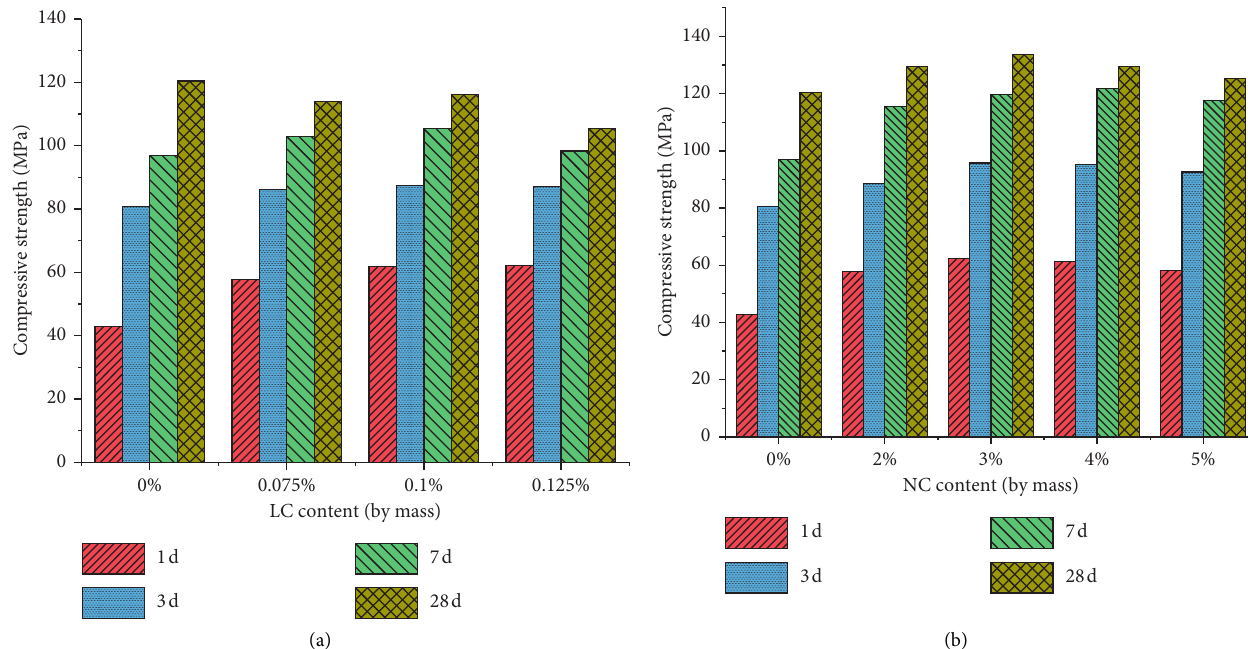
Figure 1: Effects of LC and NC single-type dosage on the UHPC comprehensive strength.